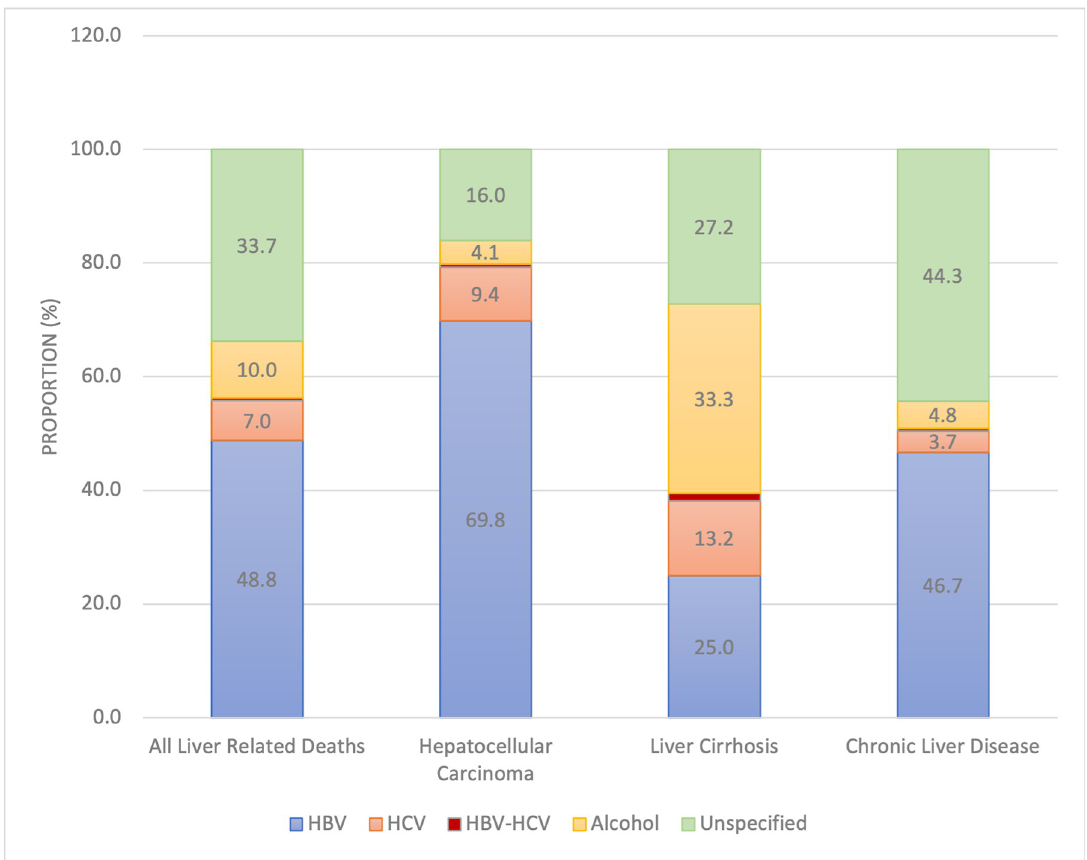
Fig 2. Proportion of risk factors associated with death from hepatocellular carcinoma, liver cirrhosis, and chronic liver disease in 11 referral hospitals in Ghana. Abbreviations: HBV- Hepatitis B Virus, HCV- Hepatitis C Virus.